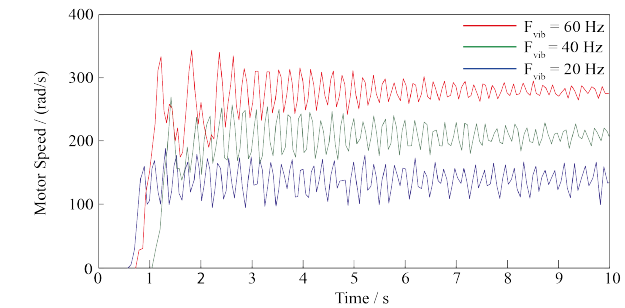
Figure 16. Measured charge balance of the start-up phase.